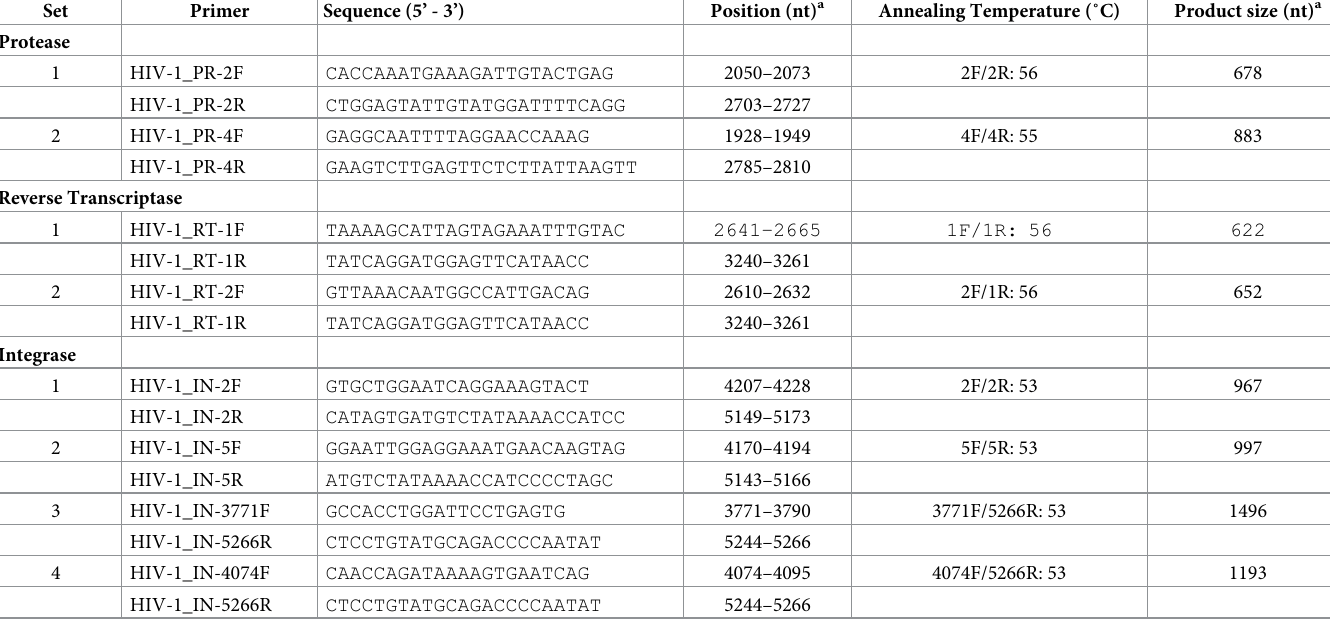
Table 1. HIV-1 PCR